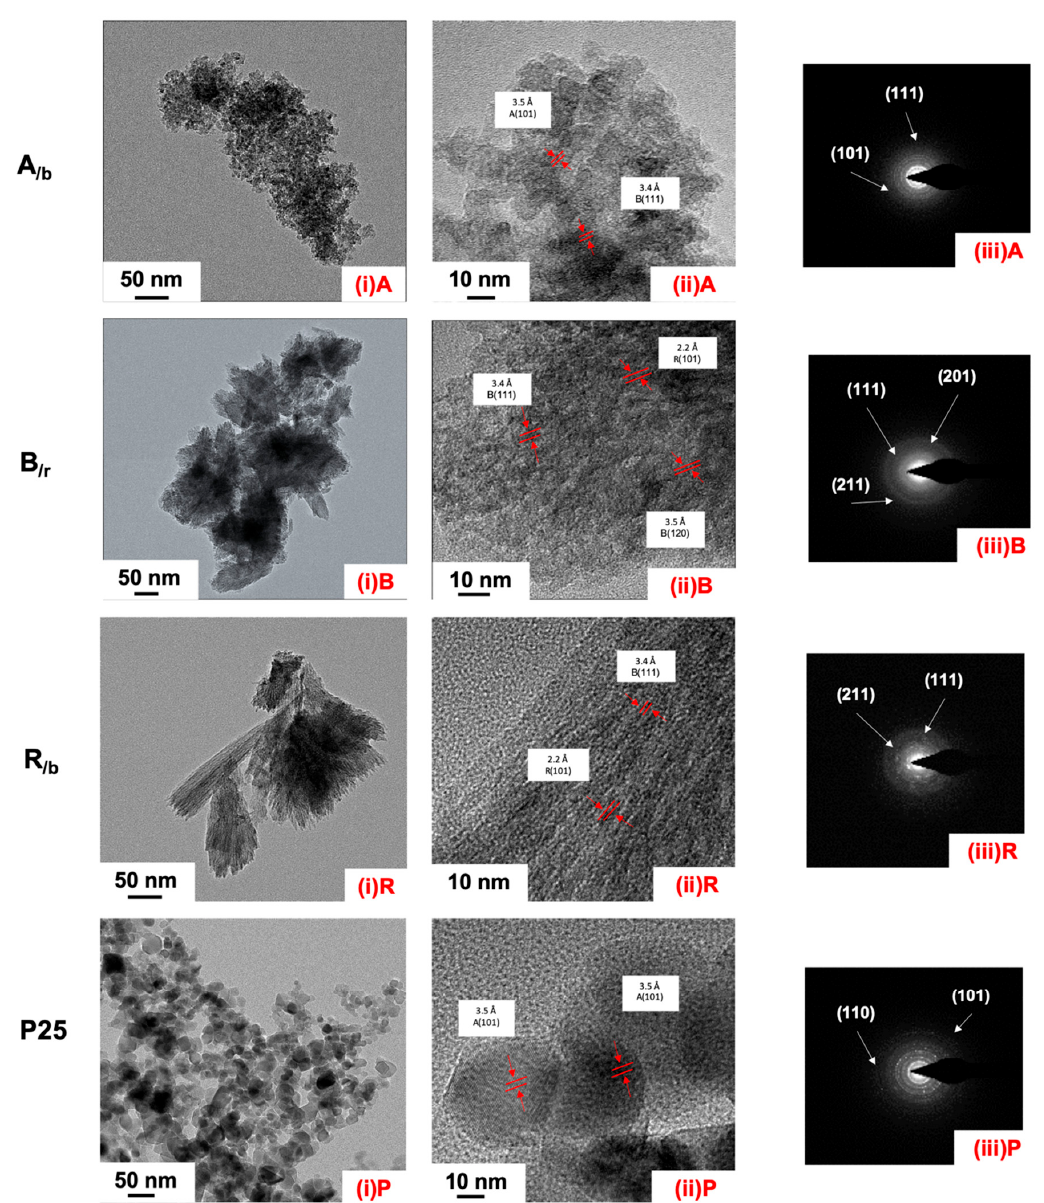
Figure 3. TEM analysis of the synthesized mixed-phase TiO 2 nanoparticles; (i) TEM images, (ii) HR-TEM images, and (iii) SAED patterns; ( A ) anatase major, A / b , ( B ) brookite major, B / r , ( R ) rutile major, R / b , and ( P ) commercial P25.